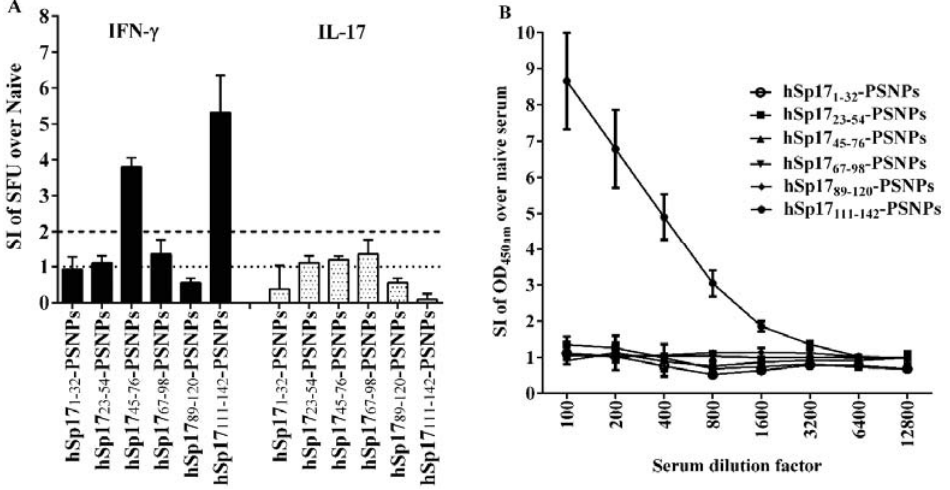
Figure 2. Immunogenicity of the hSp17 peptides based vaccines adjuvanted/carried by PSNPs. HLA-A2/K b mice ( n = 3–4/group) were immunised twice (intradermally at the